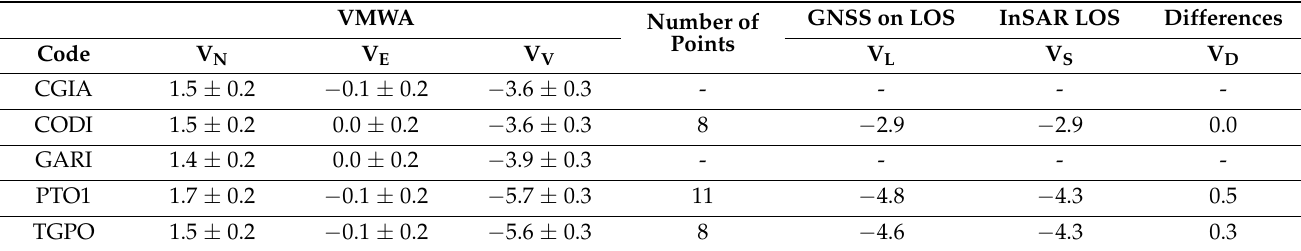
Table 4. Velocities of the three components (North V N , East V E , and Vertical V V ), in mm/year, of continuous GNSS stations obtained using the Velocity Moving Window Approach (VMWA columns) with a window of 1128 days. The velocities of the site CODI (Figure 1) were used in the reference translation procedure to align the InSAR velocities in the GNSS reference frame. V L , in mm/year, is the GNSS velocity along the LOS direction. V S , in mm/year, is the InSAR rate obtained averaging all the points in a 30 m radius. The differences between the InSAR rate and the LOS GNSS velocities of the benchmarks sites are also reported, in mm/year, in the V D column.